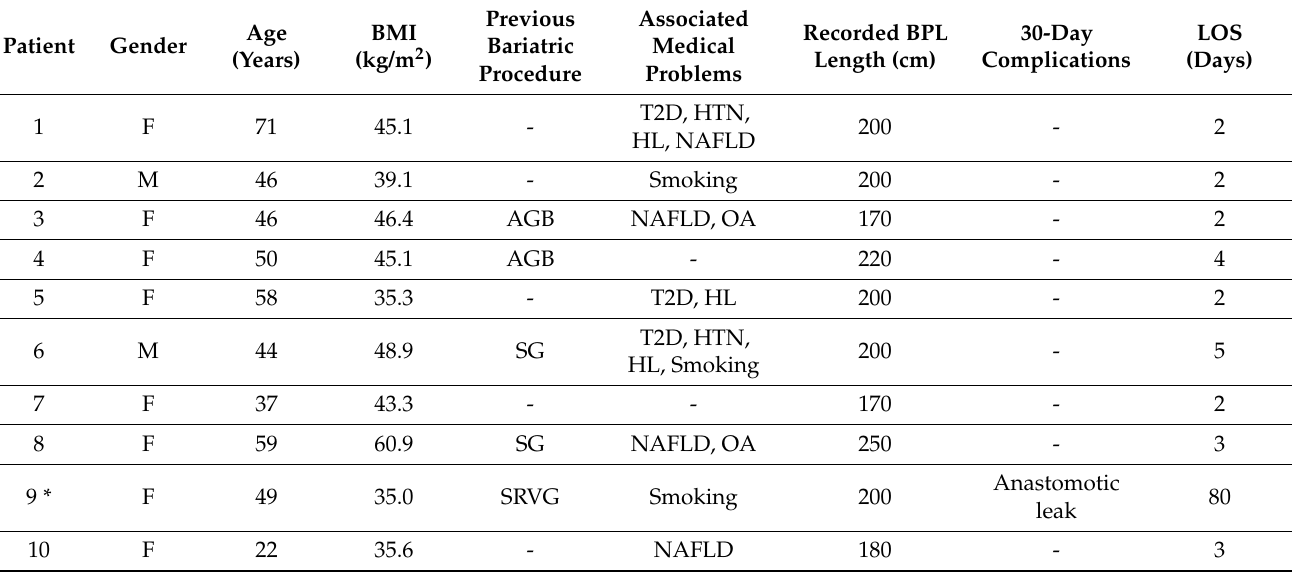
Table 1. Perioperative characteristics of